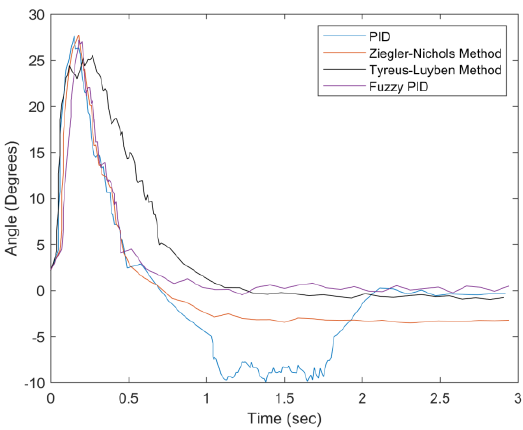
Figure 35. Tilt angle is approximately 25 degrees.